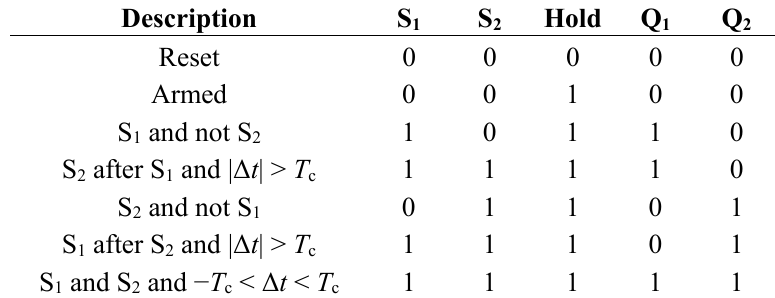
Figure 5. Complete Coincidence Detector Latch (CDL) based on the RS latch functionality, modified with a self-saving mechanism. The dotted lines indicate the border of one logic element. Table 1. Functional behavior of the Coincidence Detector Latch